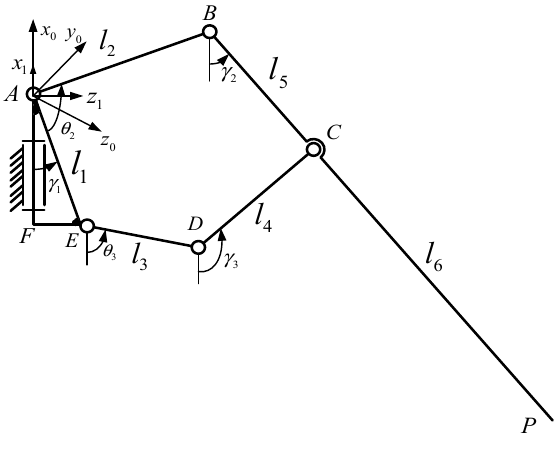
( c ) Figure 6. The three-dimensional model. ( a ) is the control module and power unit. ( b ) is the fiber plastic frame boards. ( c ) is the control platform. Two fiber plastic frame boards, 3 mm in thickness, were separated by 6 aluminum posts. The frame board was shown in Figure 6b. Three legs were arranged on each side symmetrically keeping an angle of 45° with each other. Two swimming legs were fitted in the end symmetrically keeping an angle of 90° with each other. The control module and